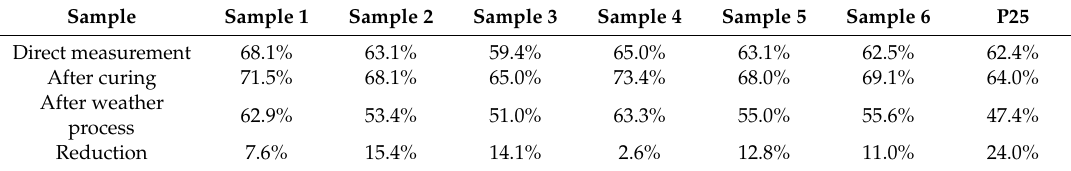
Figure 4. RhB degradation rates of WC 1-6 and WC P25 before ( a , d ) and after curing ( b , e ) and accelerated weather process ( c , f ). Table 3. RhB degradation rates and reduction values of WC 1-6 and WC P25 after